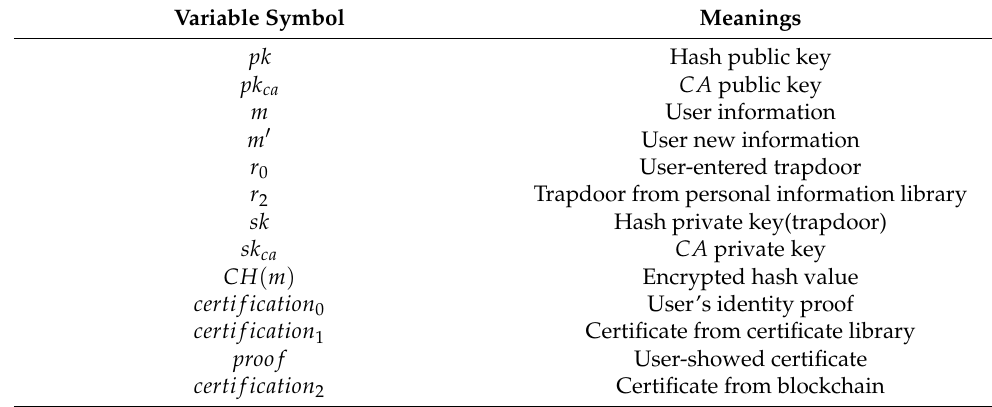
Table 1. Symbolic variables and meanings in this paper. Variable